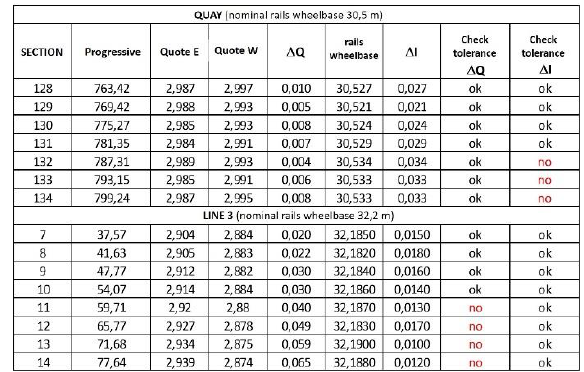
Figure 14. Testing the straightness in a vertical plane of the rail The importance of signalling of the measurement sections becomes of fundamental importance as the tolerances involved are very low.